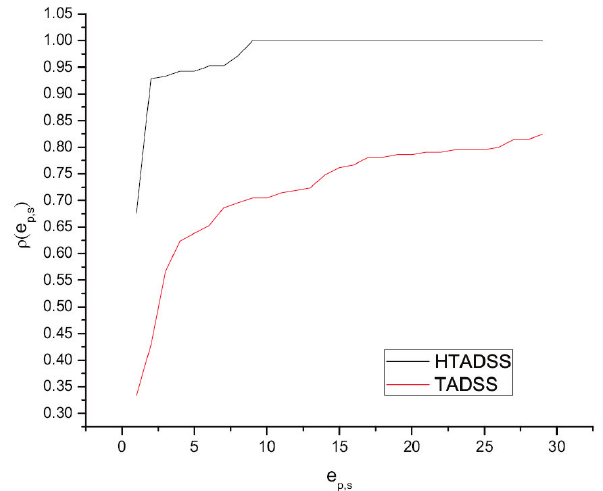
Figure 9. Performance profiles for the HTADSS and TADSS methods regarding the number of function evaluations